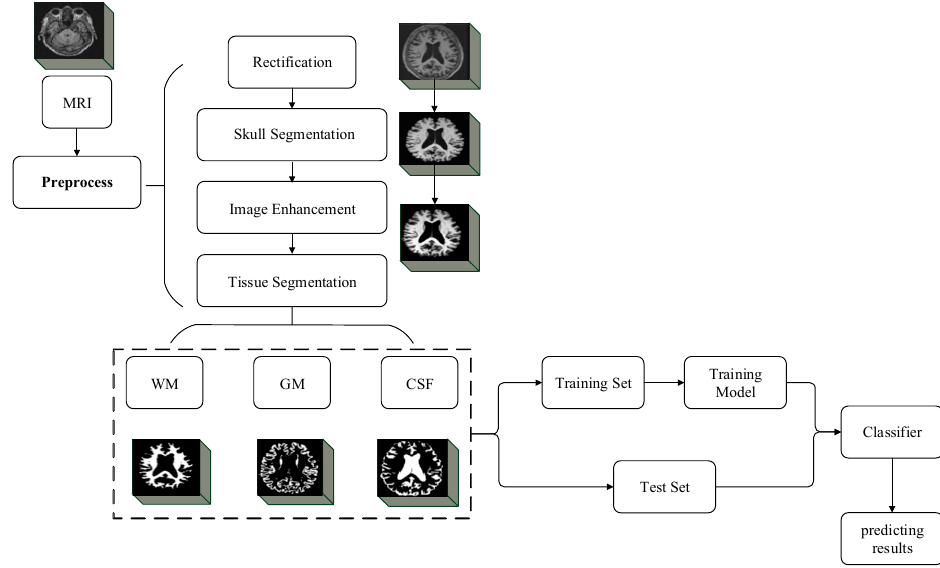
Figure 5. Experimental flow chart of the method in this